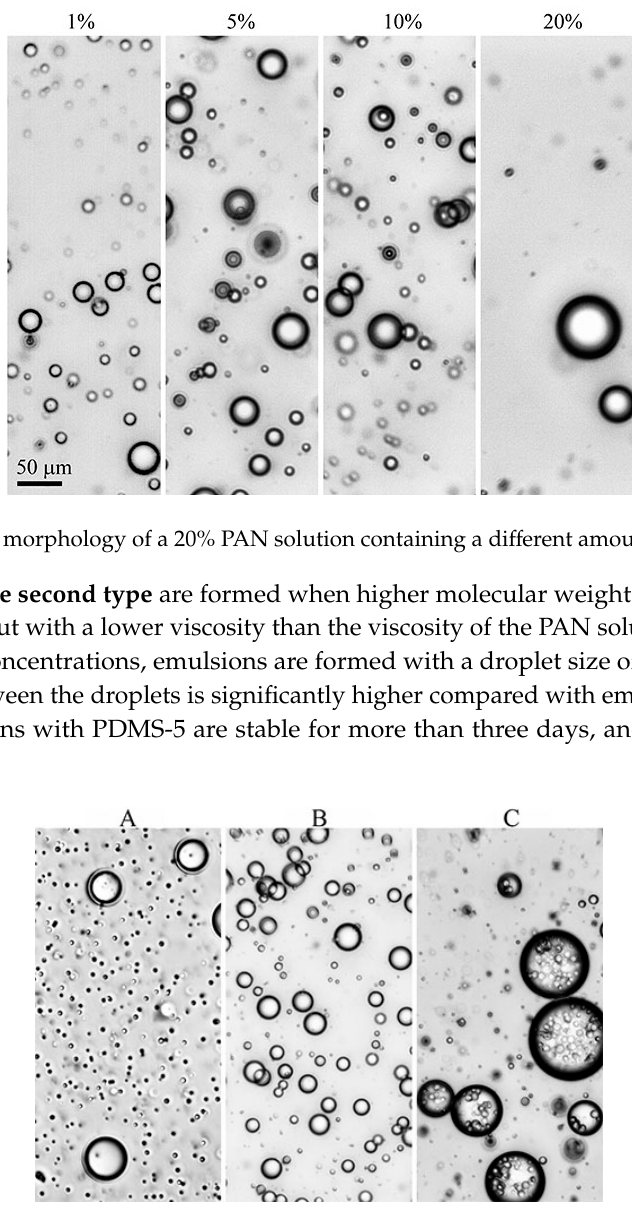
Figure 5. The morphology of a 20% PAN solution containing 5% HMDSO ( A ), PDMS-400 ( B ), or SKTN-E ( C ).